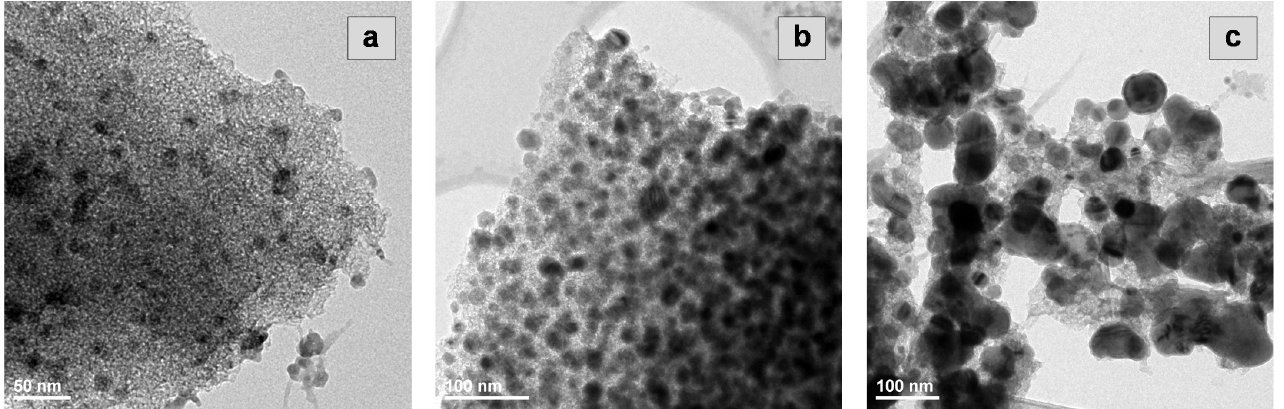
Figure 3. TEM images of the selected catalysts of ( a ) low (Ba-Co4.9/C), ( b ) medium (Ba-Co43.1/C), and ( c ) high (Ba-Co67.7/C) cobalt content (the spent catalysts after exposure to air—ex situ measurements).